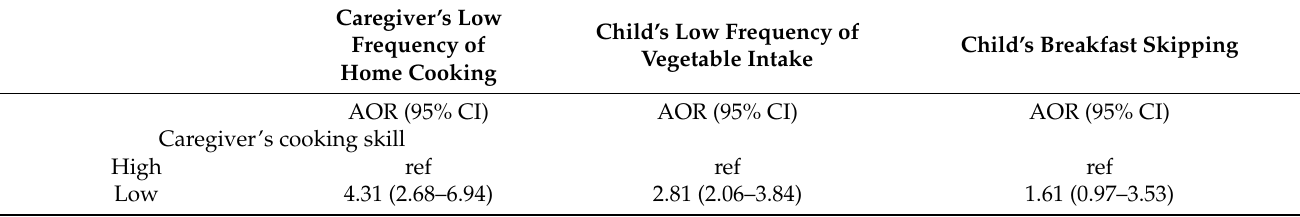
Table 3. Adjusted odds ratios of low frequency of home cooking, child low frequency of vegetable intake, and child breakfast skipping according to levels of caregiver cooking skills ( n = 5257).